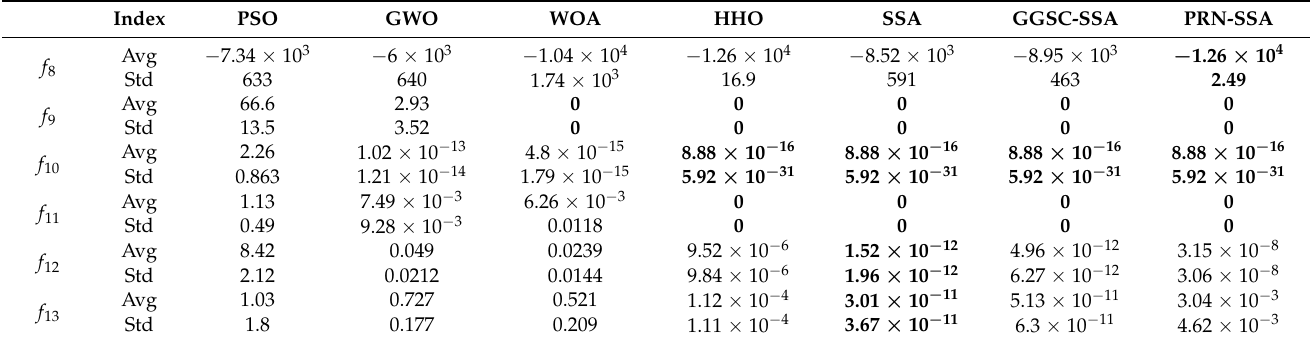
Table 5. Multimodal test functions.